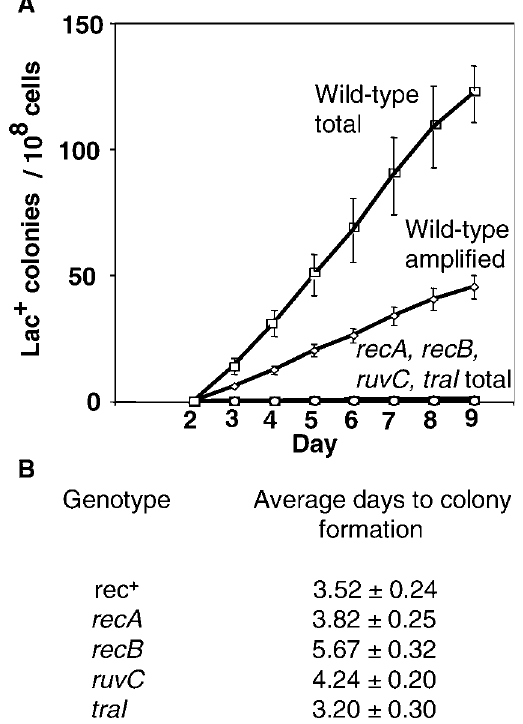
Figure 1. Homologous Recombination/DSBR Proteins Are Required for Adaptive Amplification These graphs, and similar ones below, show cumulative plots of Lac þ colonies arising per day in three or four parallel cultures under starvation on lactose minimal medium. The error bars show 1 SEM. See Table 2 for a list of all strains used. (A) recA, recB, ruvC, and traI mutants show severe depression of both point mutation and amplification under starvation. ‘‘ Total ’’ wild-type colonies (squares) are all Lac þ colonies, whether point mutant or lac amplified. lac -amplified colonies (diamonds) are distinguished from point mutants among the total colonies as previously described (see [16,24,32]) by picking total colonies from the lactose selection plates and streaking onto rich medium with X-gal dye on which lac -amplified clones form sectored blue and white colonies (see Figure 7), whereas point mutants form solid blue colonies. Strains used are as follows: ‘‘ wild- type ’’ (rec þ ) (squares and diamonds), SMR4562; recA (circles), SMR624; recB (triangles) , SMR593; ruvC (inverted triangles), SMR789; and traI (lowercase phi), SMR5232. Many of the symbols for mutant strains are obscured by others. (B) A reconstruction experiment. Mutant strains of the same five F 9 factors carrying lac amplifications of various lengths were replated on lactose minimal medium with neighbor cells to determine growth rate [24], expressed as the average number of days ( 6 SEM) taken to form visible colonies. This shows that the slow growth rate of mutant cells carrying amplification is not sufficient to explain the very low yield of amplified colonies seen in (A). Mutant lac- amplified strains are PJH428– PJH447 and PJH453–PJH457. DOI: